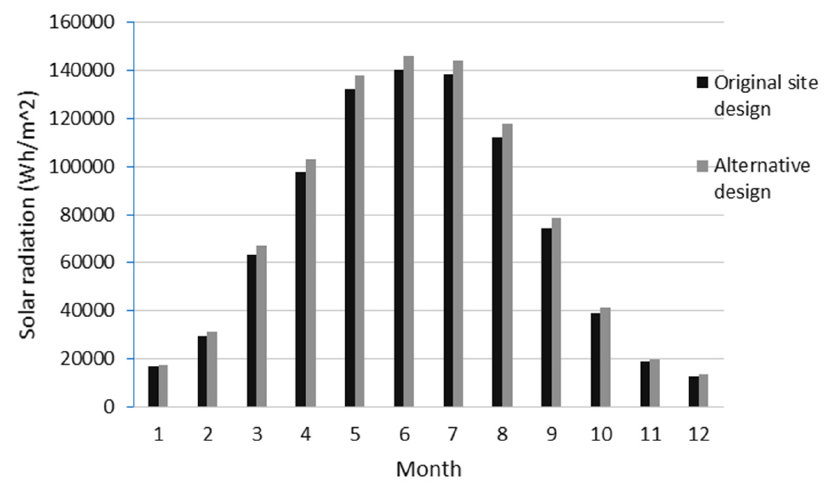
Figure 7. Monthly average hourly solar radiation of case study location in Wh/m 2